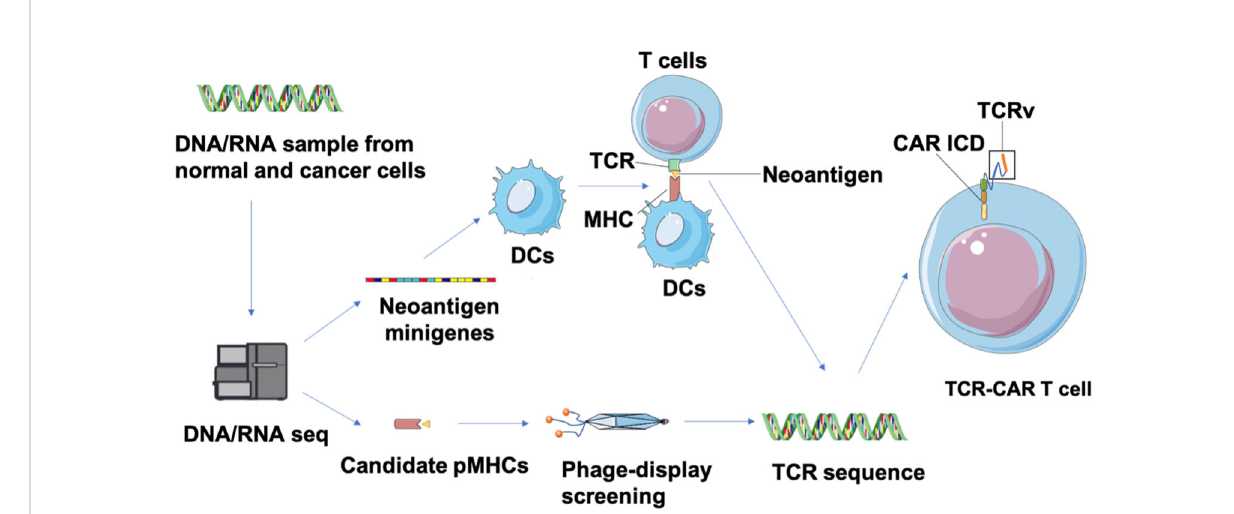
FIGURE 4 Identi fi cation of neoepitopes and development of neoantigen-speci fi c TCR-CARs. Tumor and matched healthy tissue WES/RNA-seq is fi rst performed to identity neoepitopes caused by NVM. Then, neoepitope pHMCs are employed for isolation of TCR-like antibodies through a phage- display screening. In parallel, neoantigen minigenes encoding potential neoepitopes can be designed and transfected into DCs that is co-cultured with T cells from healthy donors to obtain neoantigen-reactive T cells (89). Finally, a TCR sequence can be identi fi ed from isolated TCR-like antibodies and characterized neoantigen-reactive T cells. These TCRv genes can be used in a CAR structure to produce TCR-CAR T cells.